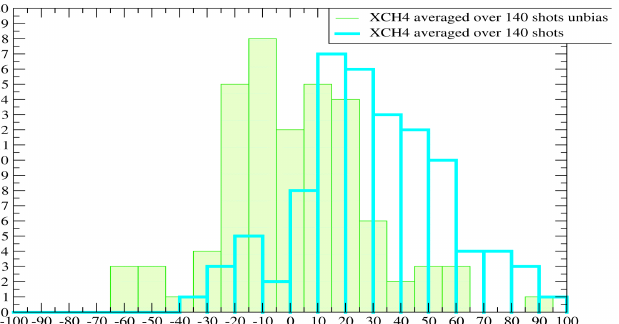
Figure 21. Histograms over 100 averages (over 140 shots) of the deviations from the true value for XCH 4 (with a sampling of 1 ppb). In blue before subtraction of the statistical bias, and in green after.